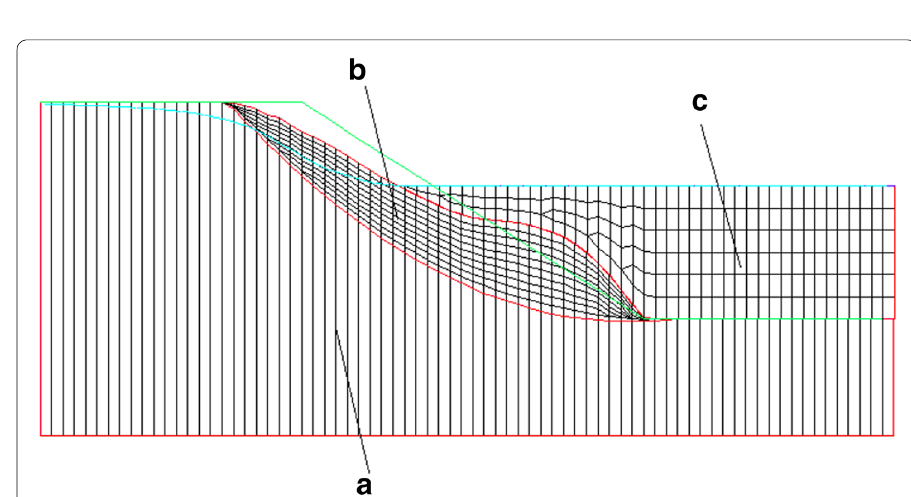
Fig. 2 Detail of the 3D grid used for the computation of the water flow and sediment transport (plan view). The uneven edges are due to the wetting/drying procedure